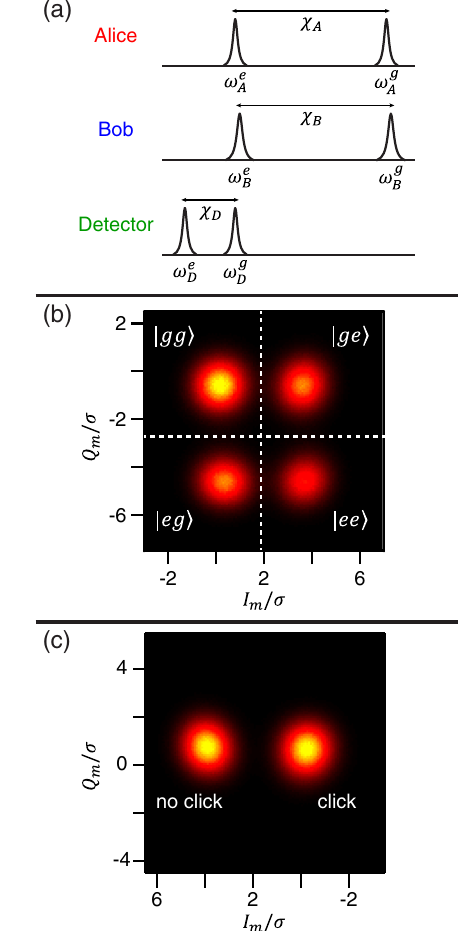
FIG. 6. Alice, Bob, and detector qubit readout spectra and histograms. (a) Alice, Bob, and detector cavity frequency spectra. The Alice and Bob cavities had nearly identical frequencies ≈ ω g ≈ χ ( ω g ) and dispersive shifts ( χ ). To perform joint A B B A readout of Alice and Bob, microwave pulses were simultaneously applied on each cavity at ω g with a relative phase of π = 2 between A the two pulses. The detector module cavity frequency ω g was D tuned to match the frequency of the photons in the experiment, ω e . The detector was read out at ω g . (b) Joint readout histogram D A for Alice and Bob. A 2 - μ s measurement pulse was used to measure the state of both qubits. The resulting output contained information about the state of Alice and Bob along the Q and I m m axes, respectively. Thus, the measurement provided single-shot readout of both qubit states, as well as the correlation between the > 90% . (c) Readout histogram for the two qubit states with F joint detector. The state of the detector qubit was measured with F > 99% in 700 m; det